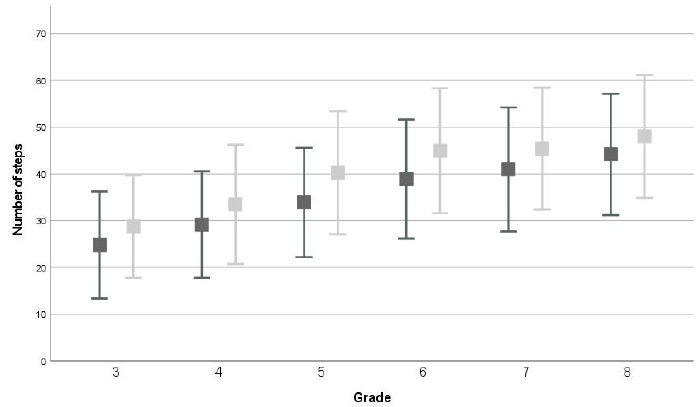
Figure 1. Average and standard deviation on walking backwards test at T0 (dark grey) and T1 (light grey).